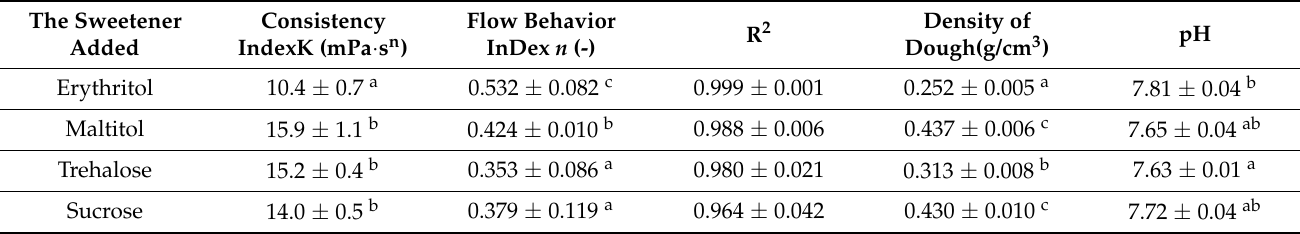
Table 1. Rheological parameters, density, and pH value of dough with sweetener (each value is presented as mean ± SD; values with the same letter in a column are not significantly different at a p <